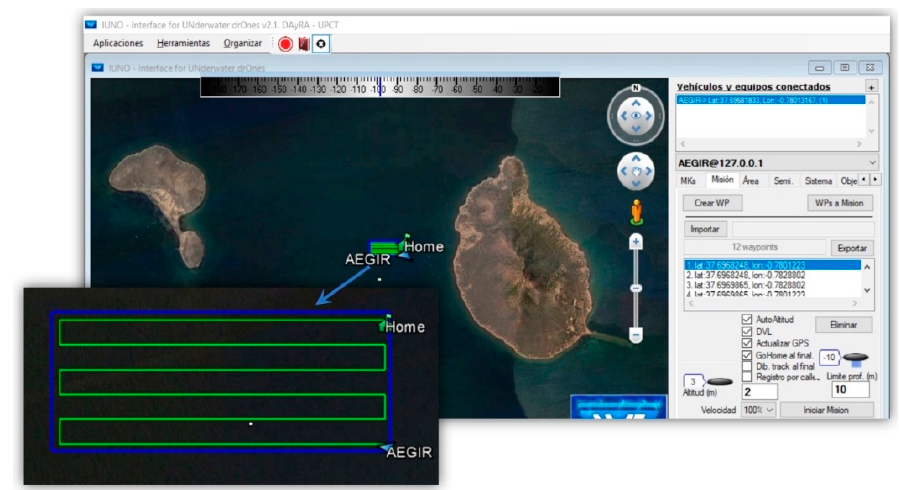
Figure 16. Mission generated in IUNO and uploaded into AUV.